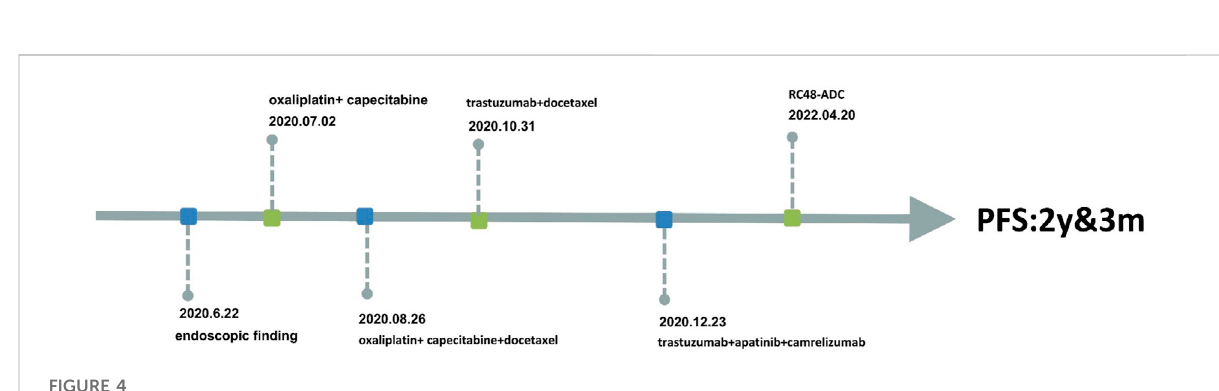
FIGURE 4 Information of this case report has been organized into a